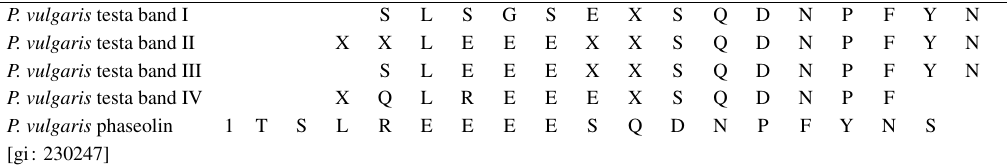
Fig. 3 – N-terminal amino acid sequences of peptides isolated (by SDS-PAGE) from the testa of Phaseolus vulgaris . The sequences of protein bands I-IV were compared with the sequence of phaseolin